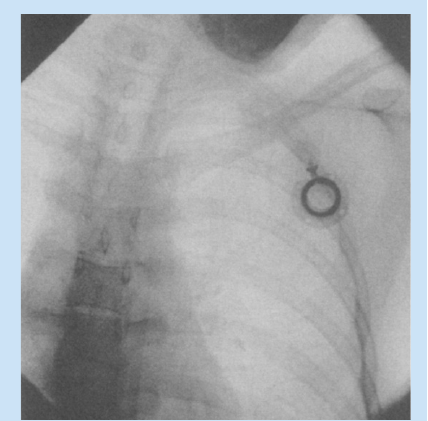
Fig. 1a. Infusoport without catheter.